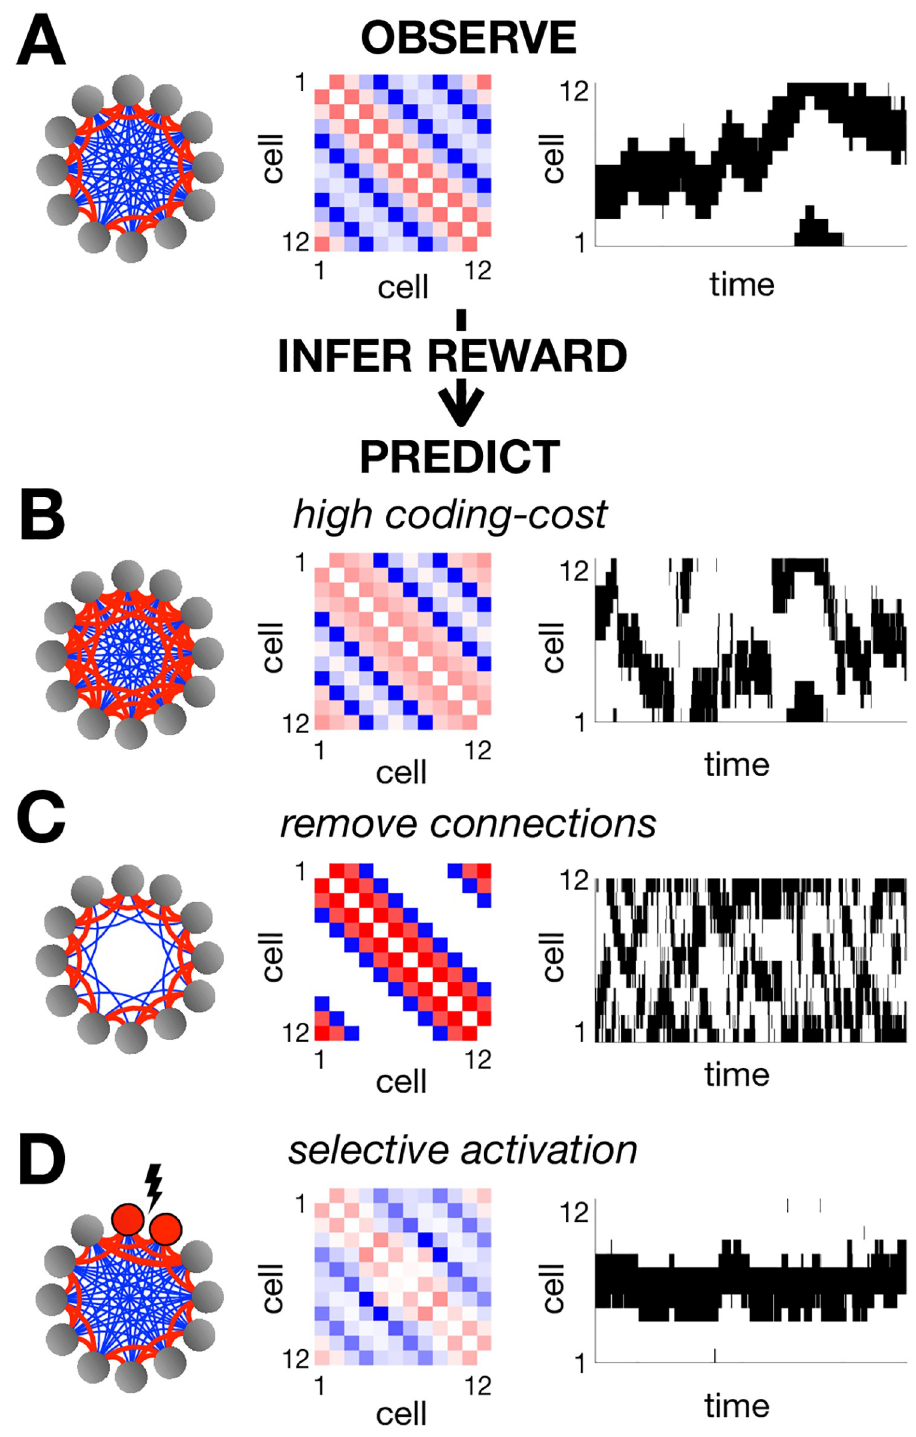
Fig 5. Pairwise coupled network. ( A ) We optimized the parameters of a pairwise coupled network, using a reward function that was equal to 1 when exactly 4 adjacent neurons were simultaneously active, and 0 otherwise. The resulting couplings between neurons are schematized on the left, with positive couplings in red and negative couplings in blue. The exact coupling strengths are plotted in the centre. On the right we show an example of the network dynamics. Using inverse RL, we can infer the original reward function used to optimise the network from its observed dynamics. We can then use this inferred reward to predict how the network dynamics will vary when we increase the coding cost ( B ), remove connections between distant neurons ( C ) or selectively activate certain neurons ( D ).